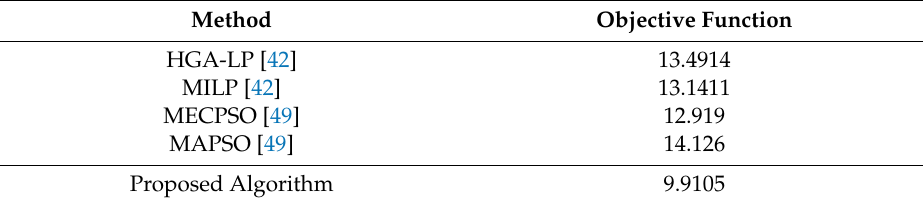
Figure 14. Convergence characteristic of WOA for the IEEE-14 bus system. Table 22. Comparison of the proposed WOA with the methods used in the literature for the IEEE 14-bus system.